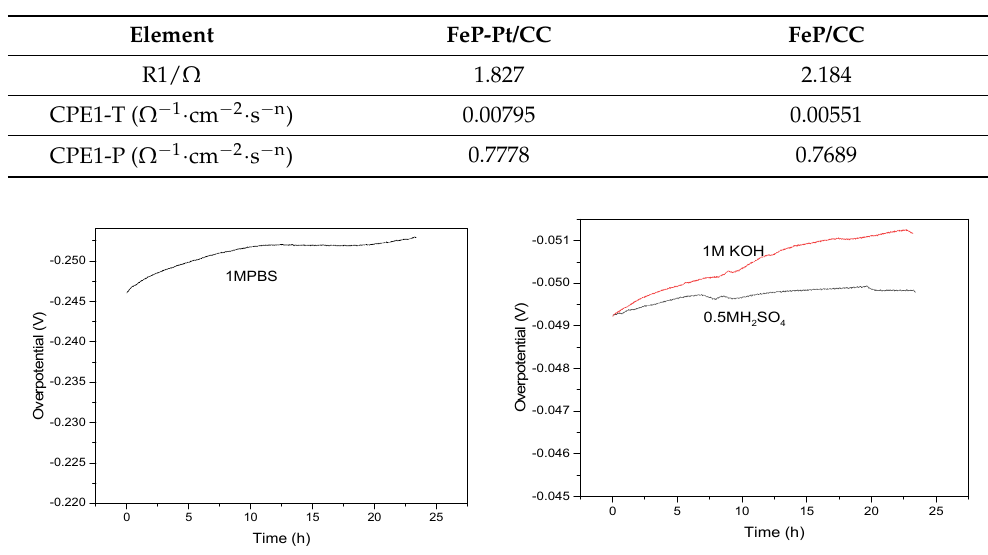
Figure 8. Time dependence of Overpotential for NiCo 2 P x at 10 mA/cm 2 (in 0.5 M H 2 SO 4 , 1 M KOH and 1 M PBS).